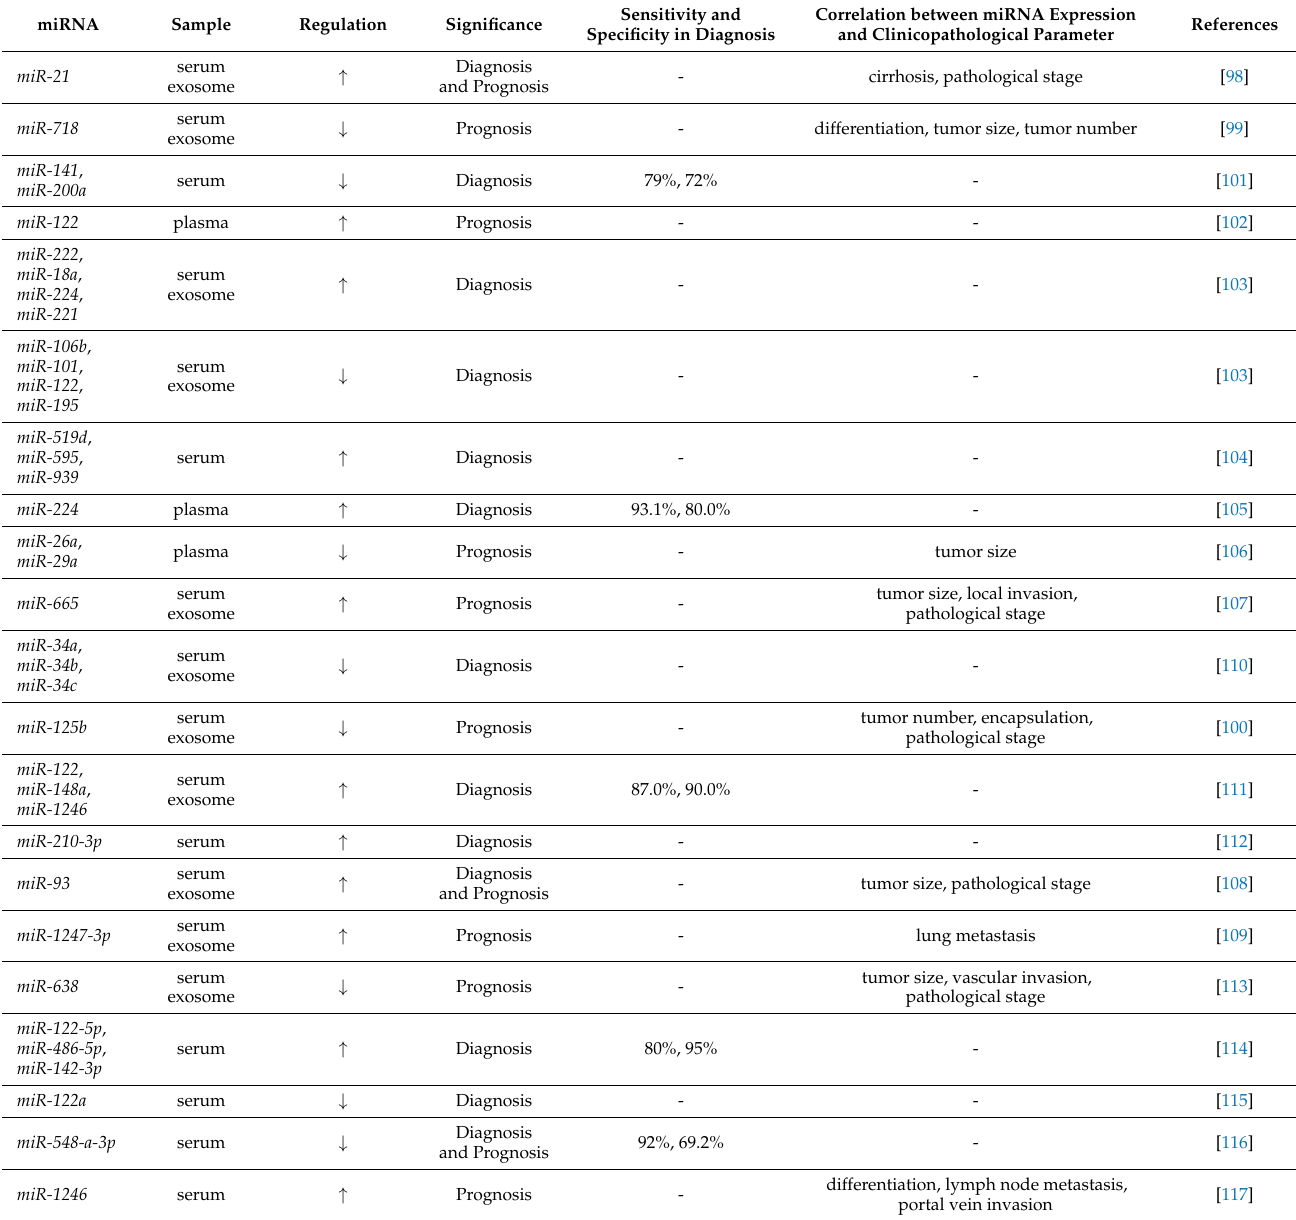
Table 4. Hepatocellular